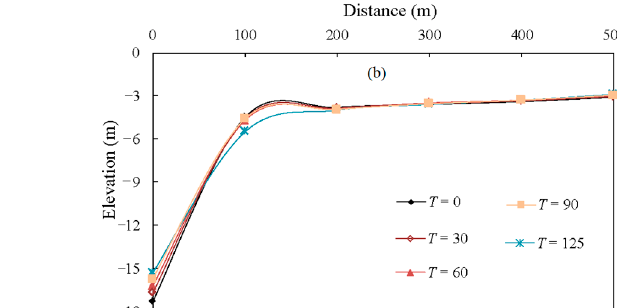
Figure 19. Change in scour-hole depth in the confluence.